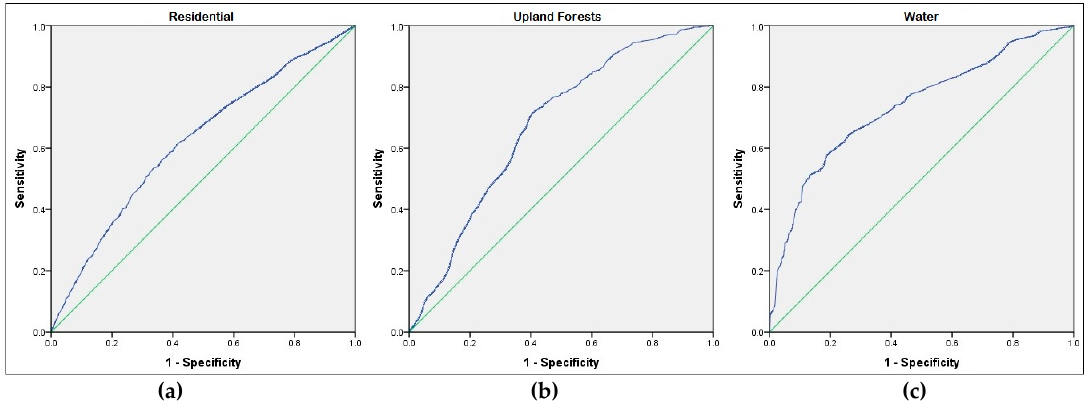
Figure A4. Receiver-operating characteristic (ROC) curves to evaluate binomial logistic regression models of driving factors for ( a ) “Residential”, ( b ) “Upland Forests”, and ( c ) “Water” classes.